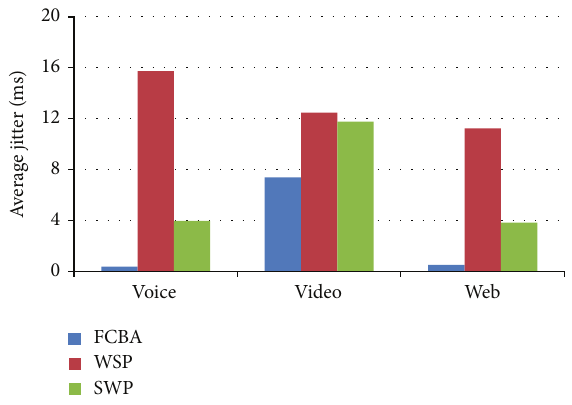
Figure 9: Average jitter values of the traffic classes.